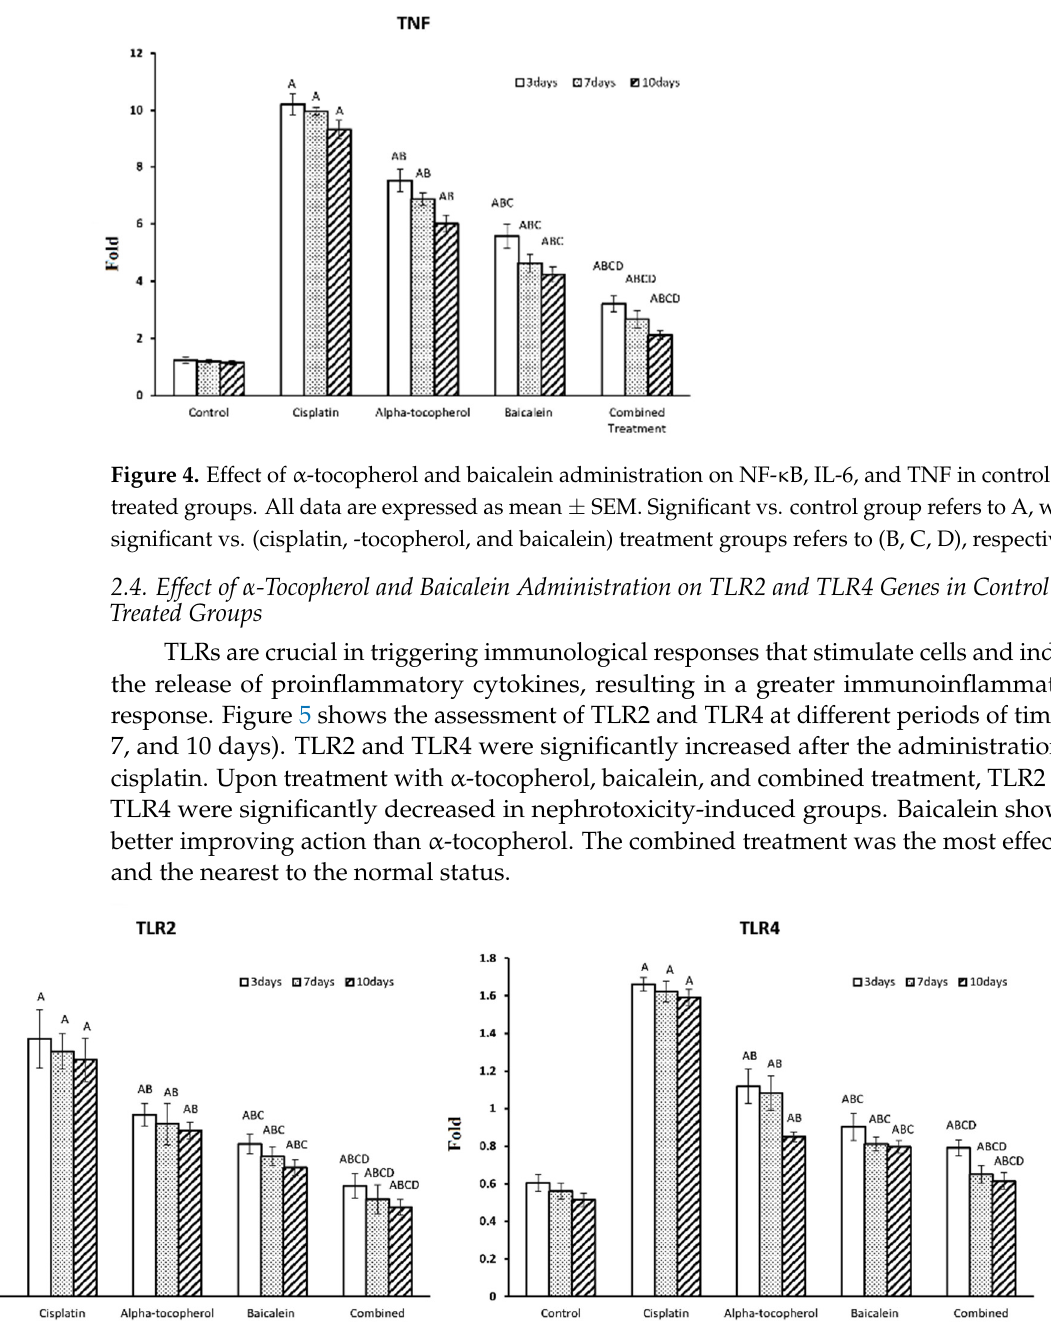
Figure 6. Effect of α -tocopherol and baicalein administration on Keap-1 and NRF-2 in control and treated groups. All data are expressed as mean ± SEM. Significant vs. control group refers to A, while significant vs. (cisplatin, -tocopherol, and baicalein) treatment groups refers to (B, C, D), re- spectively.